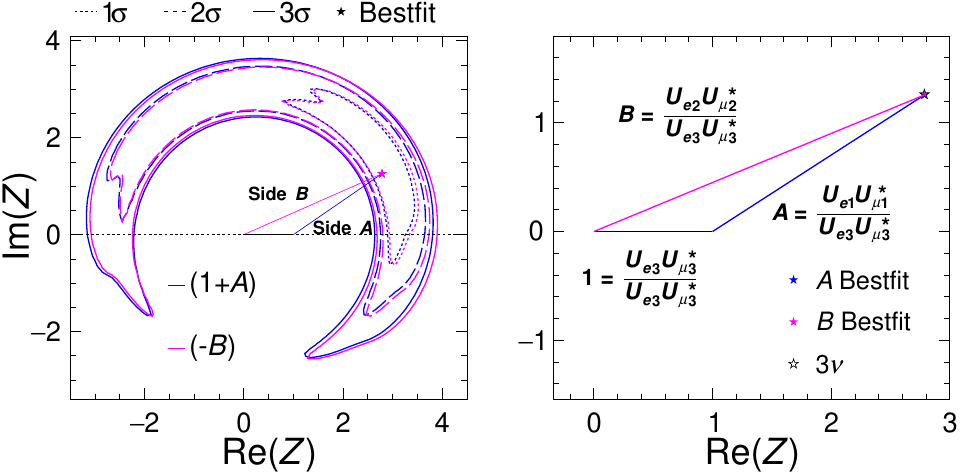
Figure 4 . e − µ unitarity triangle without assuming unitarity. Left: allowed regions for the complex numbers (1 + A ) = (1 + U e 1 U ∗ /U e 3 U ∗ ) (blue) and ( − B ) = ( − U e 2 U ∗ /U e 3 U ∗ ) (violet). µ 1 µ 3 µ 2 µ 3 Right: zoom-in of the e − µ unitarity triangle without assuming unitarity. The triangle consists of three sides A , B and C , parameterized as in eq. (4.6). The best-fits of the endpoints of A and B are (2 . 7871 + 1 . 2573 i ) and (2 . 7876 + 1 . 2569 i ) , shown as blue and violet stars. The best-fit of the vertex of the unitarity triangle assuming unitarity ( 2 . 7858 + 1 . 2629 i ) is also shown (open star) for comparison. For both panels, the x-axes are the real parts and the y-axes are the imaginary parts. All of them have non-zero imaginary parts, indicating preferences for CP violation. The endpoints of side A and B look coincident, and the e − µ triangle is nearly